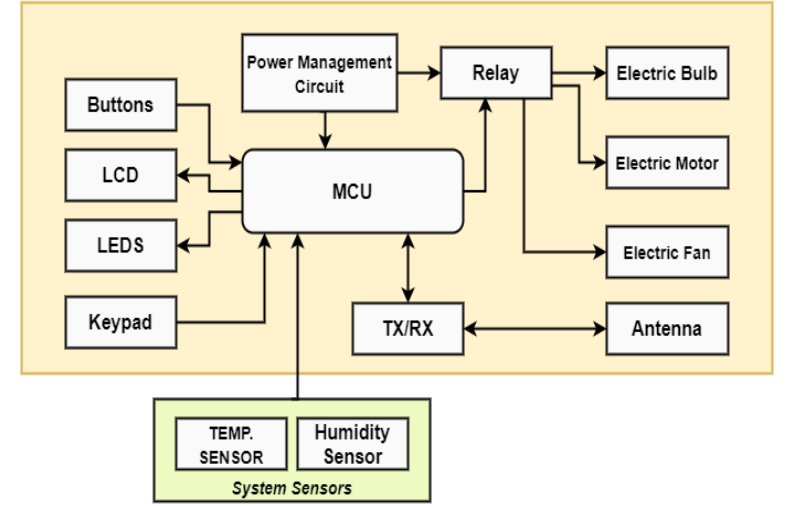
Figure 2. DigiIncubator hardware block